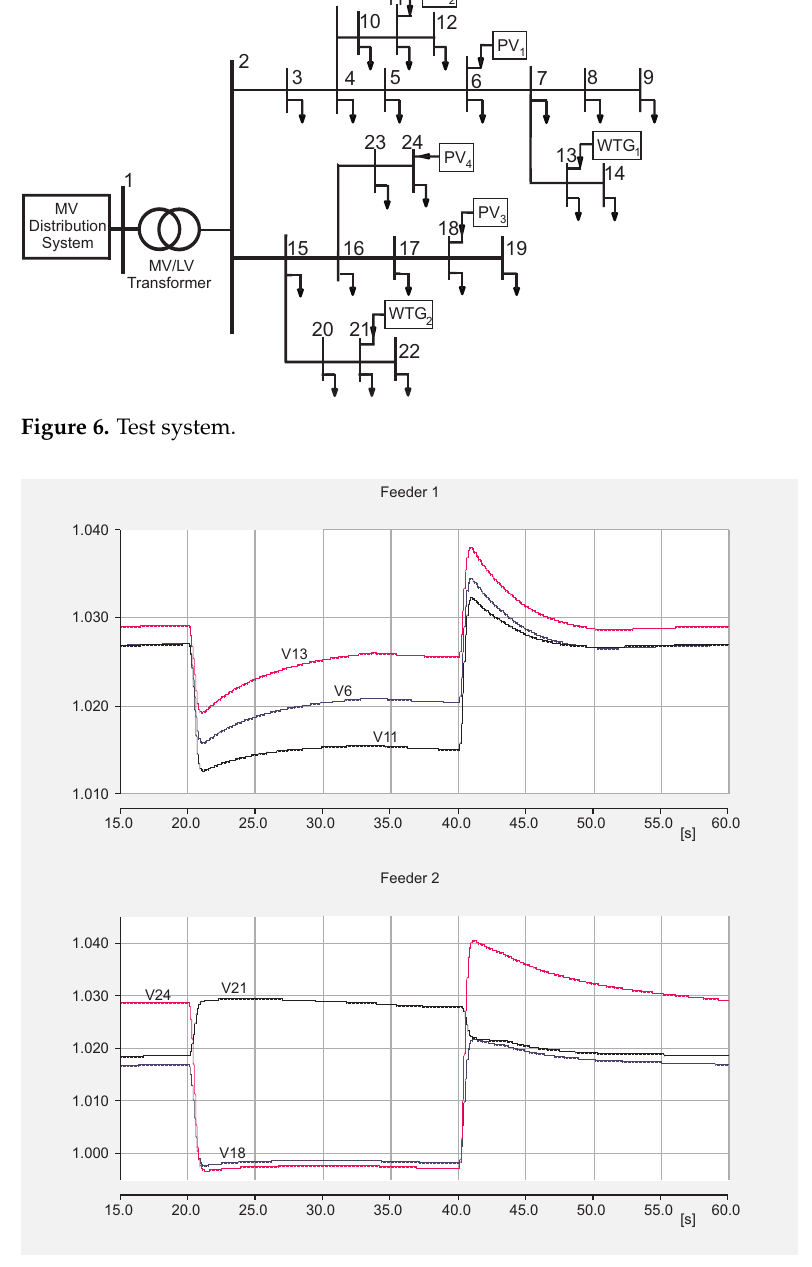
Figure 7. Time evolution of the voltages in presence of variation of the solar irradiance. Conversely, Figure 8 reports the time evolution of the same regulated voltage in the presence of variation in the wind speed. In particular, the PVs are subject to a 1000 W/m 2 constant solar irradiance. The WTGs are subject to a variable wind speed; in particular the wind speed decreases from 10 m/s to 5 m/s and afterwards increases up to 8 m/s. Addi- tionally, in this case, the controllers guarantee SG robust stability and voltage